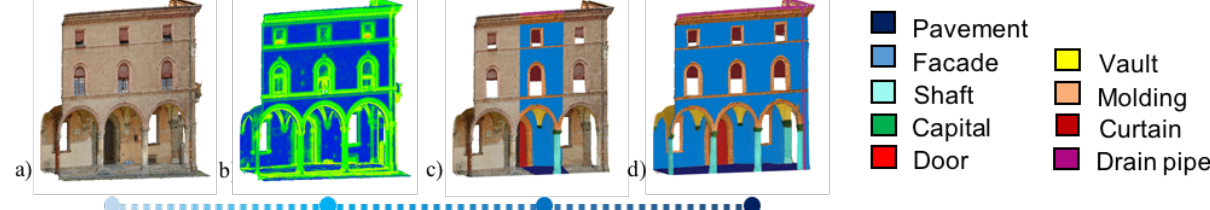
Figure 1. 3D classification process based on artificial intelligence: surveyed point cloud (a), automated features extraction (b), manual annotation of a small portion to define classes (c), final automated classification results